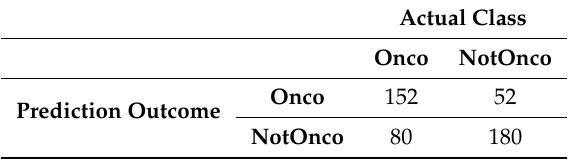
Table 1. Onco/NotOnco classification accuracy: confusion matrix on the test